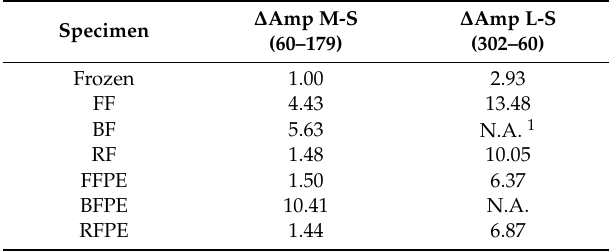
Figure A3. Chromatogram of no template control of the digestion reaction including S1 nuclease and its 1x reaction buffer. Table A1. ∆ Amp of mt-CO1 gene for mouse livers